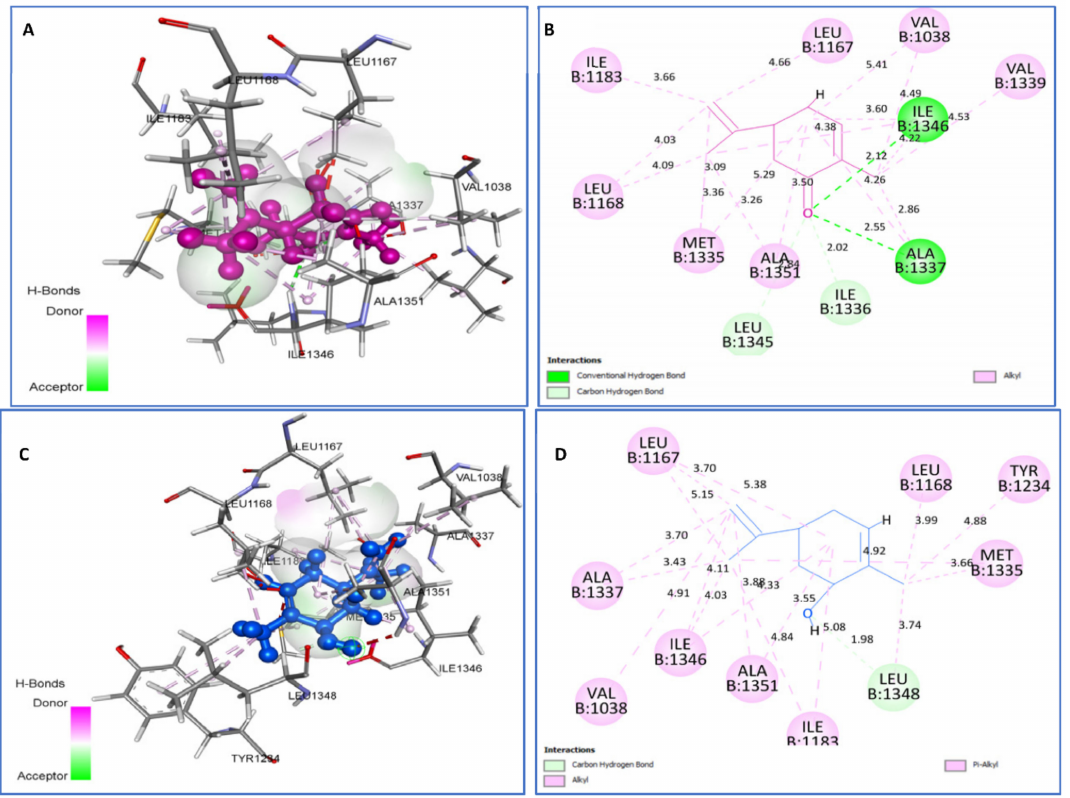
Figure 6. Two-dimensional (2D) and three-dimensional (3D) residual interactions network of carvone ( A , B ) and cis -carveol ( C , D ) with the active site of topoisomerase II DNA gyrase (PDB Id: 2XCT)